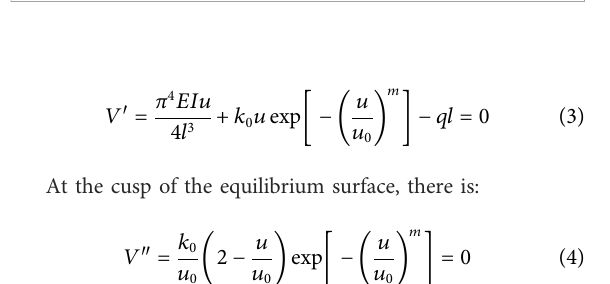
FIGURE 7 Three-dimensional numerical simulation